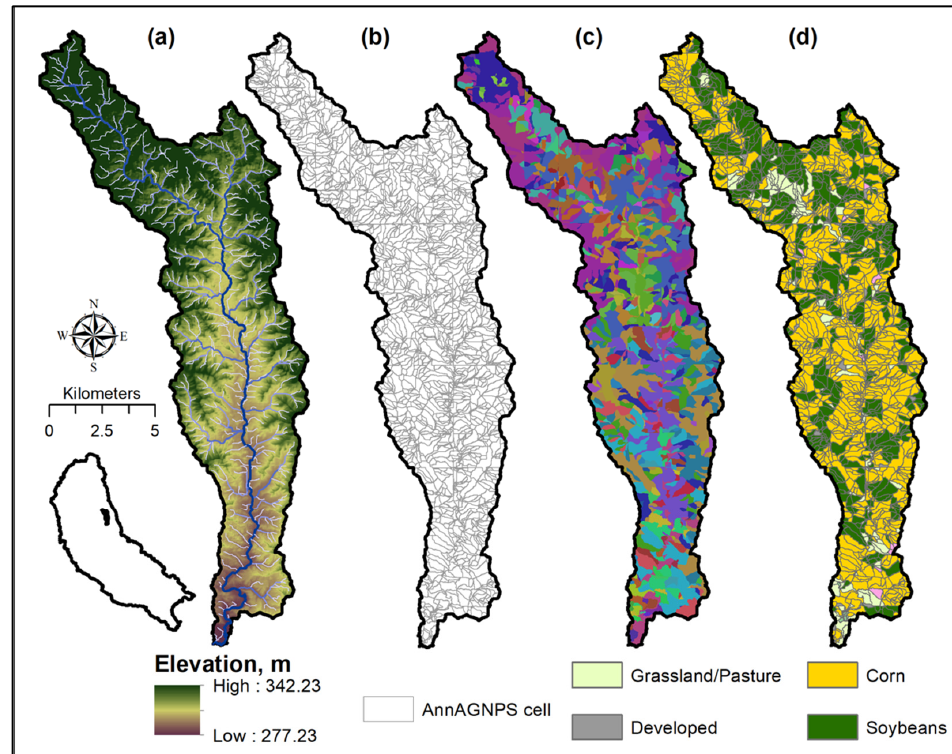
Figure 5. Illustration of sub-watershed topographic characterization and discretization. Topographic analysis combined with user-provided topographic thresholds to determine channel network ( a ) and division into sub-catchments, referred to as AnnAGNPS cells ( b ). Each sub-catchment is linked to climatic stations, soil type ( c ), and yearly land use/land cover ( d ) information using GIS zonal statistic methods.